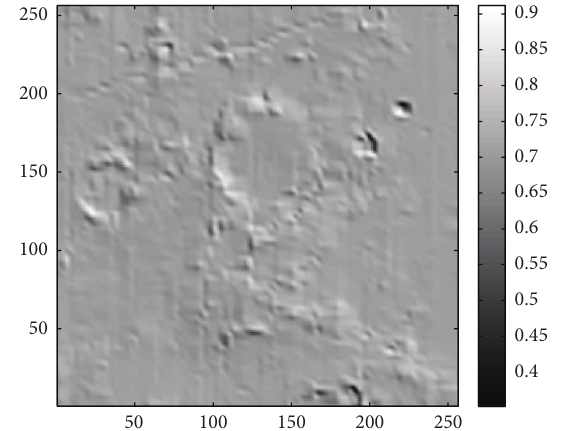
Figure 14: Simulation result of the terrain with diffusion (size: 256 × 256